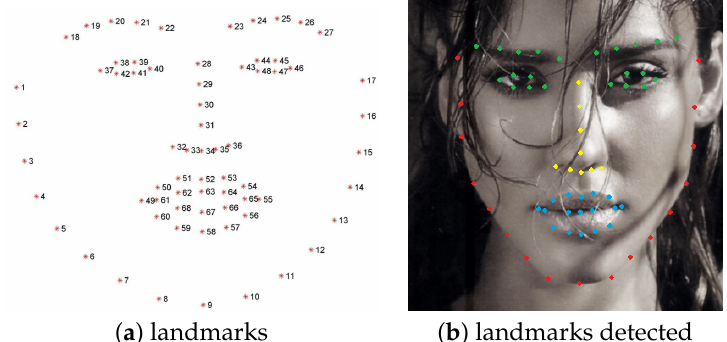
Figure 5. ( a ) Landmarks numbered from 1 to 68; ( b ) Landmarks detected on a face. We can identify 5 areas: face line (red landmarks [1–17]), eyebrows [18–27], and eyes [37–48], both in green (we call